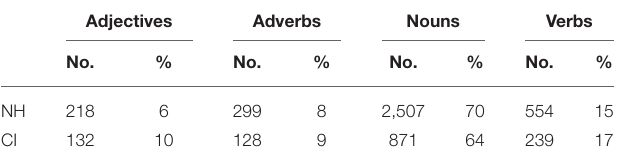
TABLE 2 | Distribution of content words in